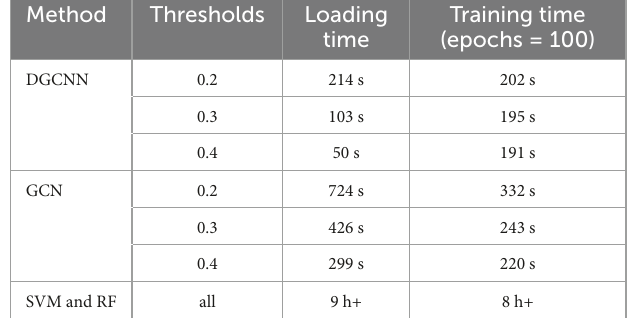
TABLE 4 The time cost of dataset loading and training under various thresholds for deep graph convolutional neural network (DGCNN).